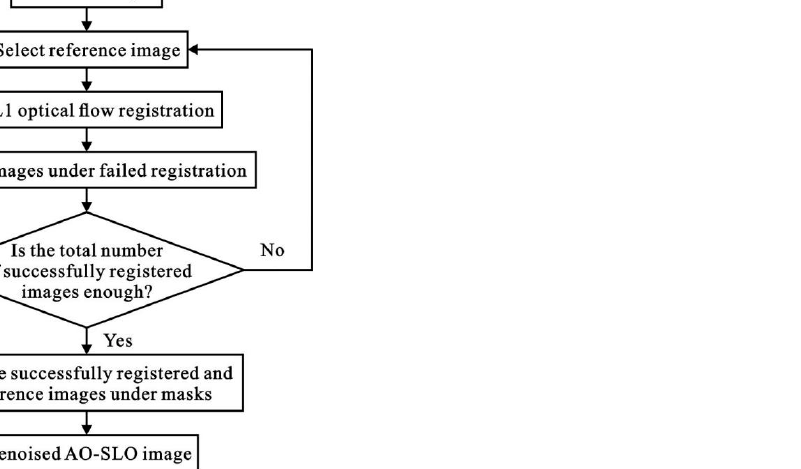
Figure 2. Flowchart of adaptive optics scanning laser ophthalmoscope (AO-SLO) image denoising.